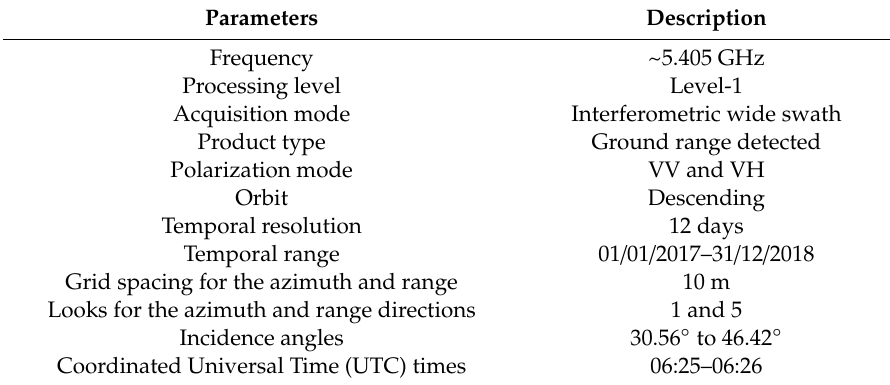
Table 1. Parameters for the Sentinel-1A